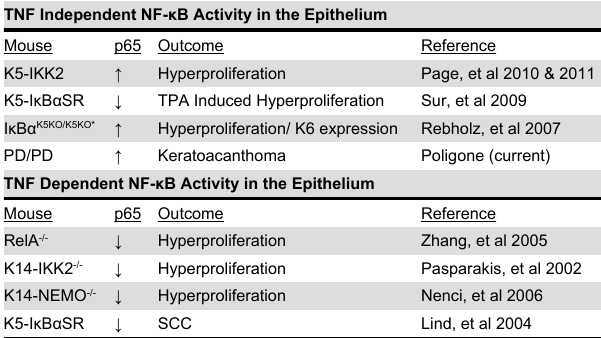
Table 1. NF-κB activity in the